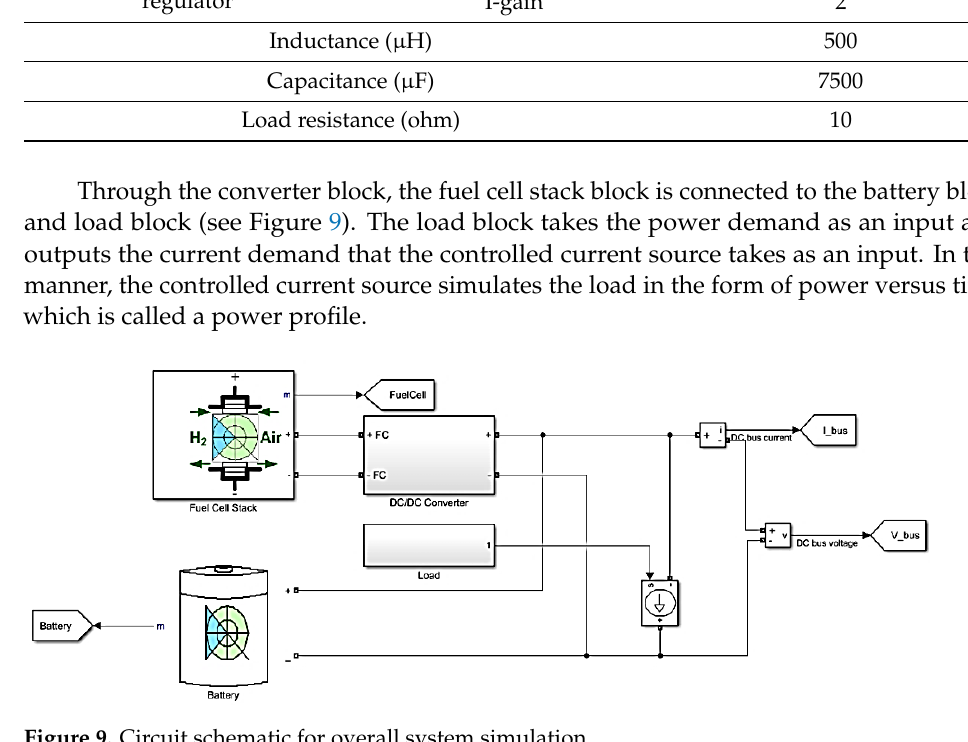
Figure 9. Circuit schematic for overall system